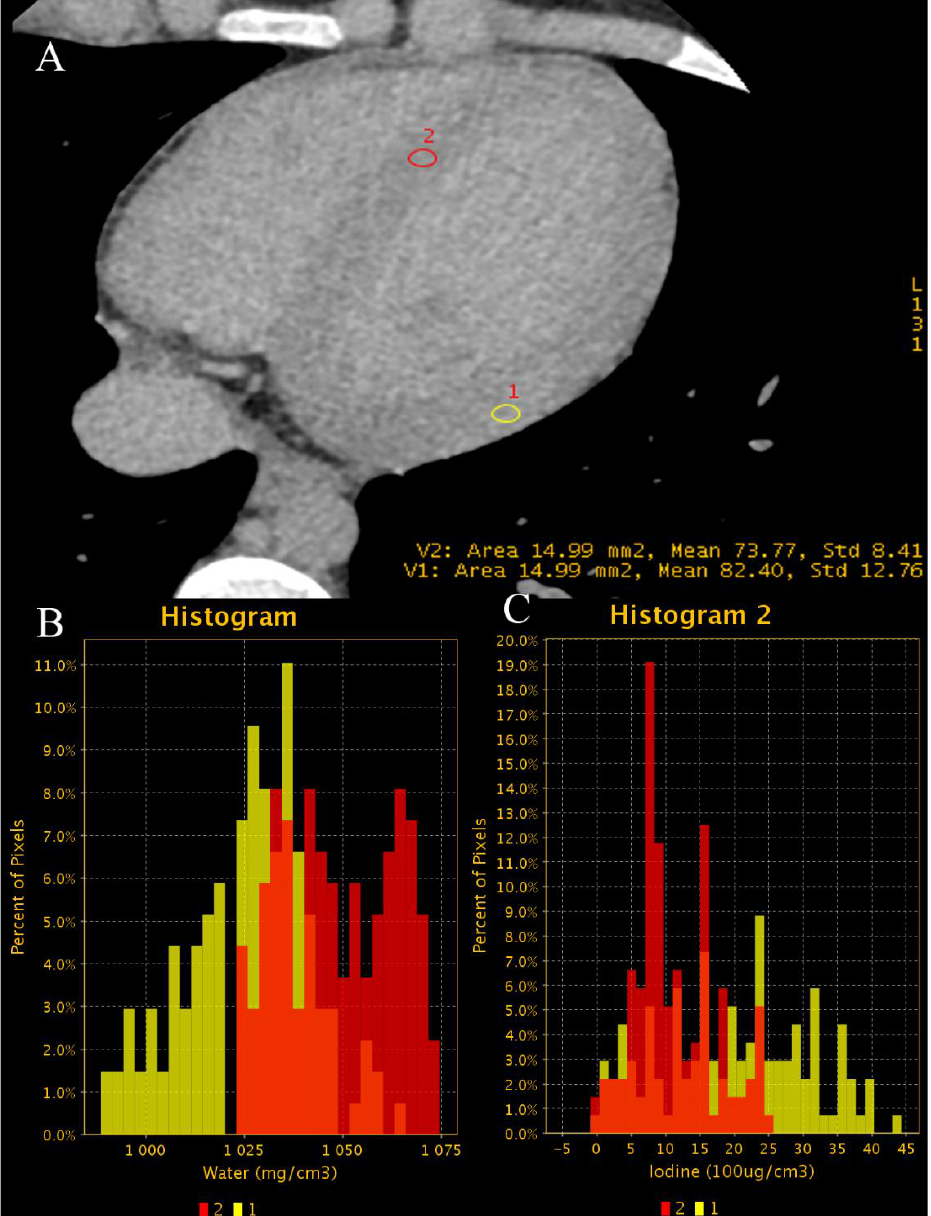
Figure 6. At 70 keV VMI, the subepicardial region of lateral wall of increased density is visible in delayed phase ( A ); it is caused by increased iodine uptake and reduced water concentration ( B , C